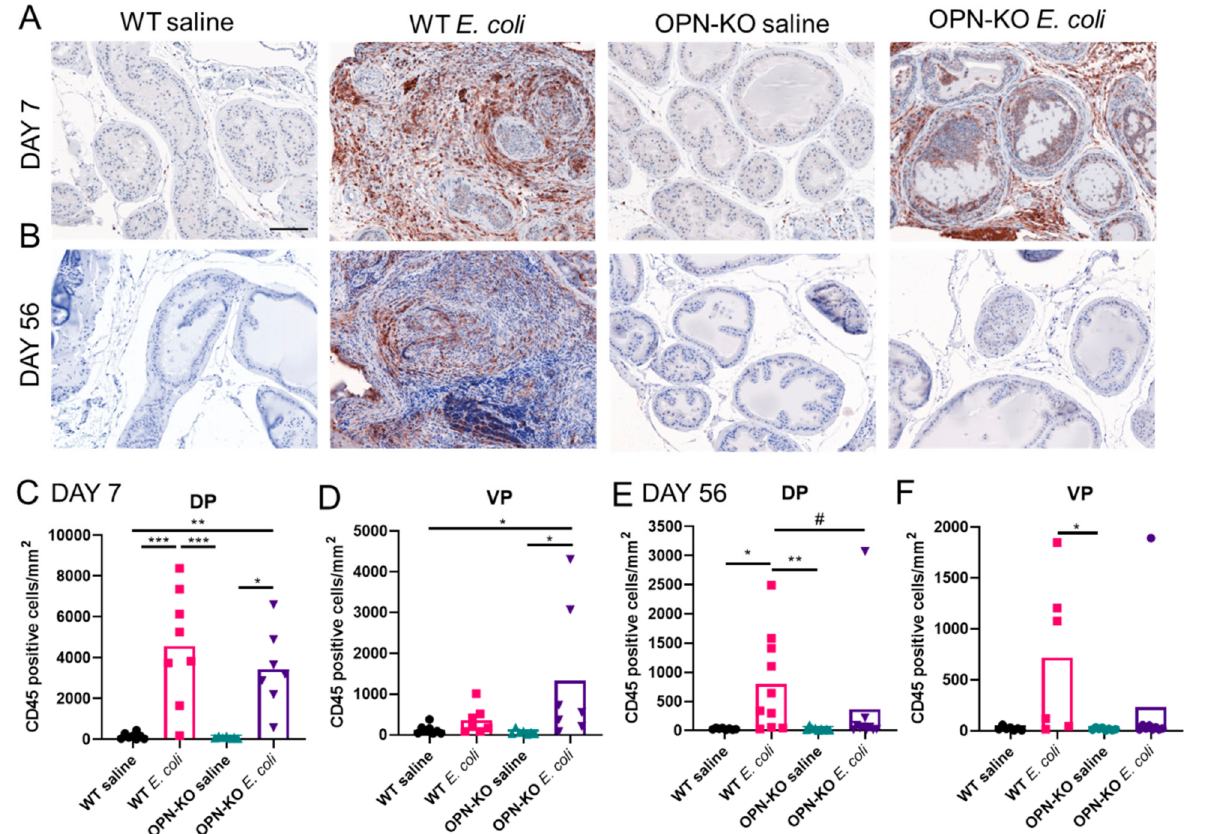
Figure 4. Inflammatory cell numbers decrease over time in osteopontin knockout (OPN-KO) mice. Panels ( A , B ) show representative images of CD45 staining 7 and 56 days after the first E. coli - or saline instillation. Panels ( C , D ) show comparison of CD45+ counts across experimental groups in the dorsal (DP) and the ventral prostate (VP) at day 7. Panels ( E , F ) show comparison of CD45+ cell numbers in saline and E. coli -instilled wild type (WT) and OPN-KO mice 56 days after the initiation of the experiment. CD45+ cells were identified using immunohistochemistry and were counted and normalized to tissue area. Images were captured at 20 × magnification. Scale represents 100 µ m. * multiple analysis with Kruskal–Wallis test, # pair-wise comparison with Mann–Whitney test between WT E. coli and OPN-KO E. coli mice. *,# p < 0.05; ** p < 0.01; *** p <